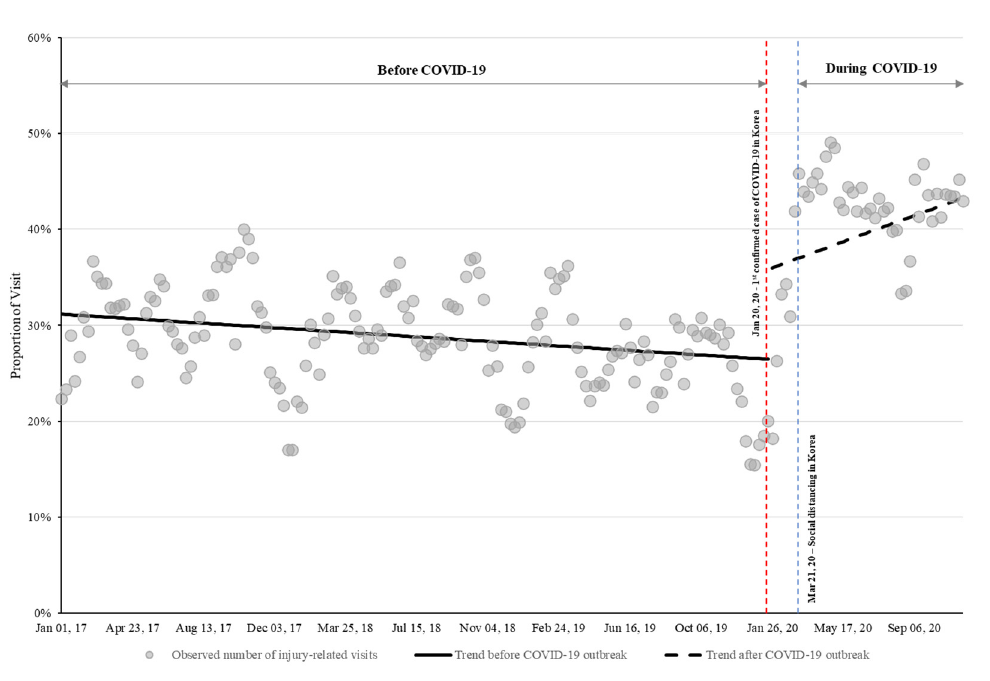
Figure 2. Segmented regression analysis of the weekly proportion of injury-related patient visits to PEDs. Compared to before the COVID-19 pandemic, the proportion of injury-related patient visits significantly increased ( p < 0.001); COVID-19: coronavirus disease, PED: pediatric emergency department.